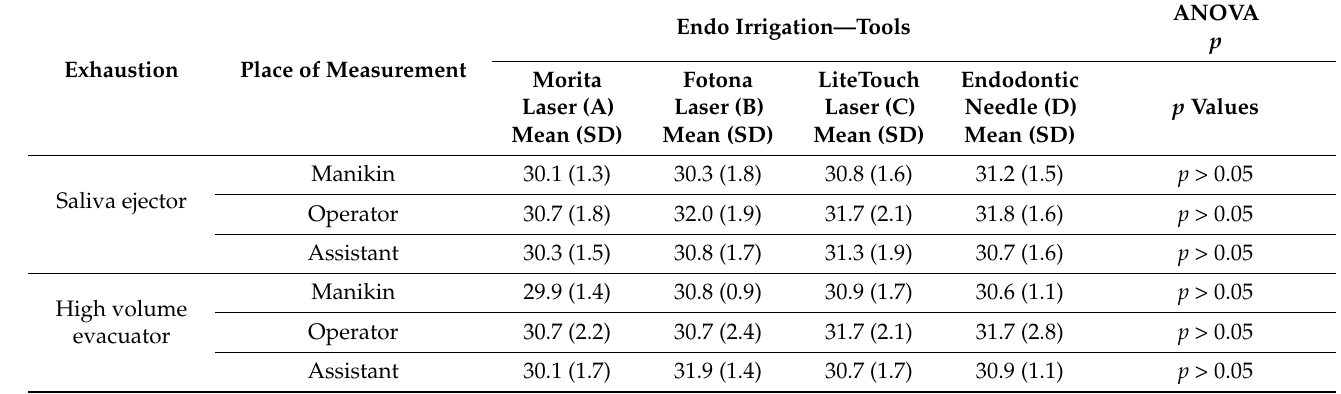
Table 5. The level of aerosol particles ( × 103) measured at manikin, operator, and assistant mouths, (Mean (SD)) during endodontic